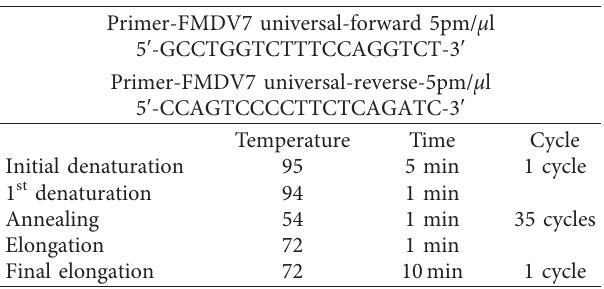
Figure 1: Gum and tongue lesion observed on cattle infected with foot and mouth disease. Table 1: The Universal primers and thermal cycle used for am- plification of